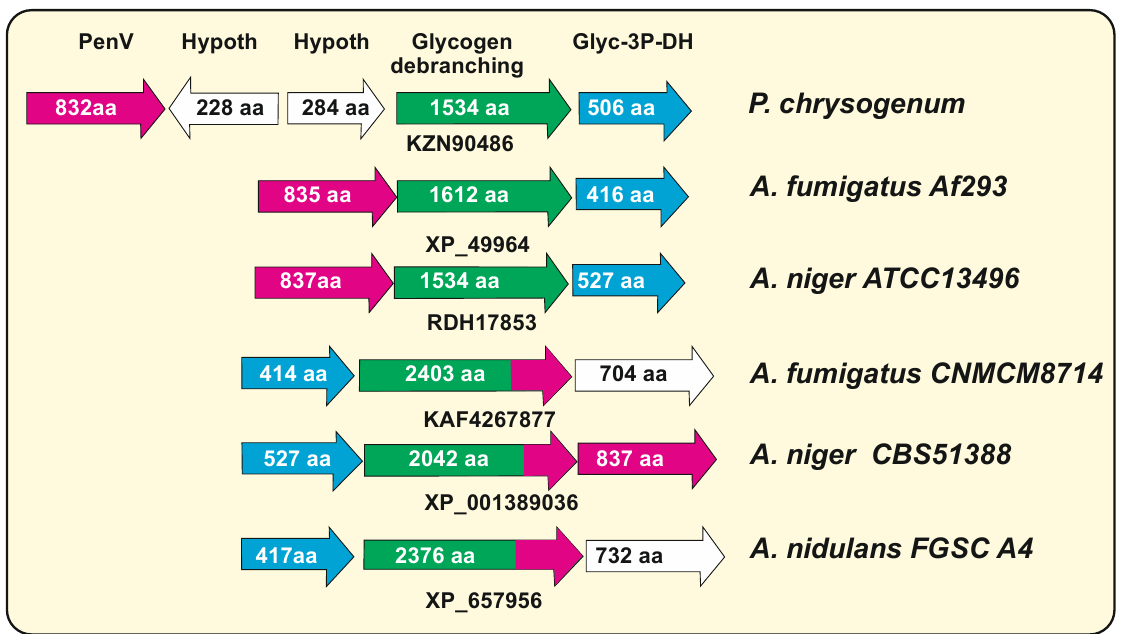
Figure 3. Gene organization of genome region encoding PenV and the glycogen debranching enzymes in different filamentous fungi, listed at the right of the figure. PenV-encoding genes are shown in pink color; genes for glycogen-debranching enzymes are shown in green; genes for glyceraldehyde-3P-dehydrogenase are shown in blue. Hypothetical or unrelated genes are in white. The accession numbers for the respective debranching enzyme are shown below the gene. The amino acid number is indicated inside the arrows. Note that in fused enzymes, the amino terminal moiety is labeled in green, and the carboxy-terminal region is in pink. In A. fumigatus CNMCM8714 and A. nidulans FGSC A4, the fused protein includes a complete PenV protein (800 and 832 aa, respectively), whereas in A. niger CBS52388, the fused protein contains only 504 aa of PenV; in addition, this fungi contains a separate adjacent penV gene.